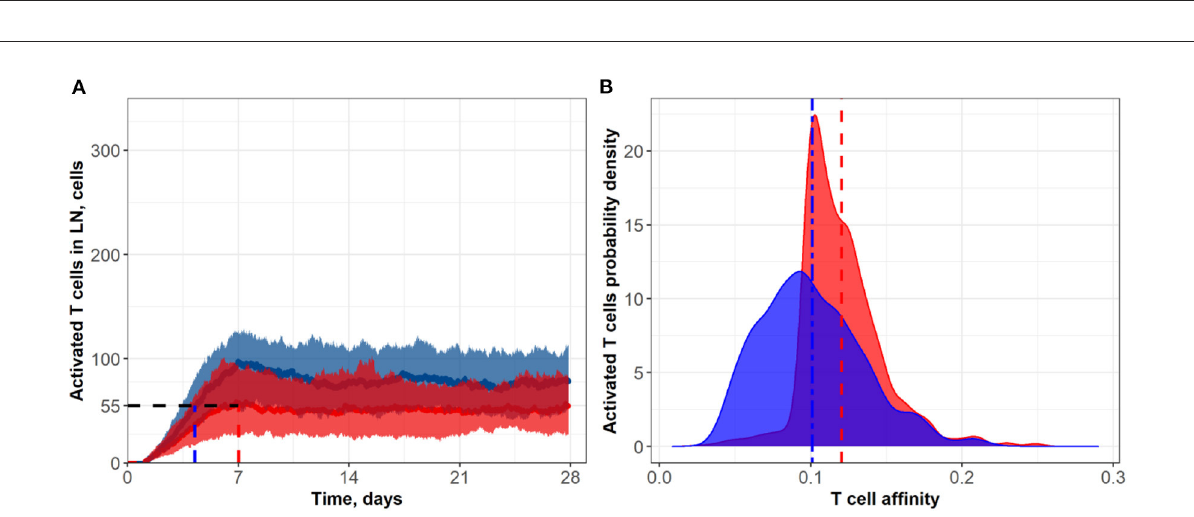
FIGURE4 (A) Population dynamics of activated T cells in the LN T zone during immune response initiation: Control conditions (red) and after administration of an anti CTLA-4-blocking antibody (blue). (B) Affinity distributions of activated T cells: Dotted vertical lines represent mean affinities for control and anti CTLA-4 conditions. Simulations were run under scenarios with different affinities that corresponded to a semi-maximal duration of short contacts, K prolif : 0.1 (blue; anti CTLA-4 conditions) and 0.2 (red; control). Corresponding data files are available at the free repository GitHub at: